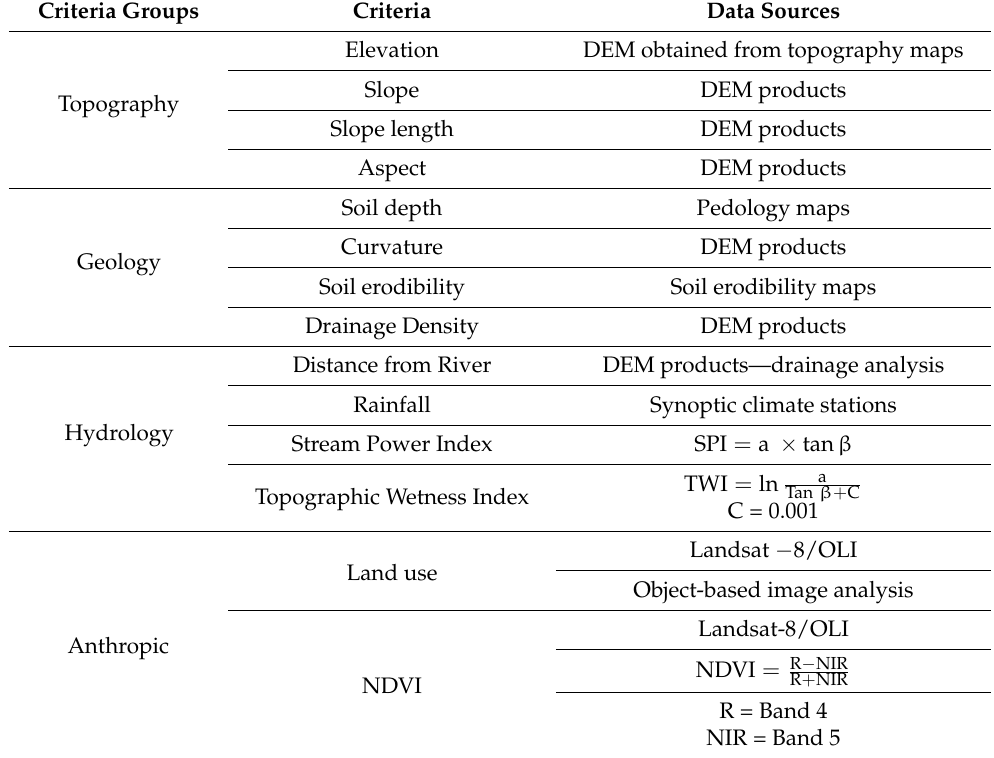
Table 5. Selected criteria, initial data sources, and mathematical representation of methods used for soil degradation